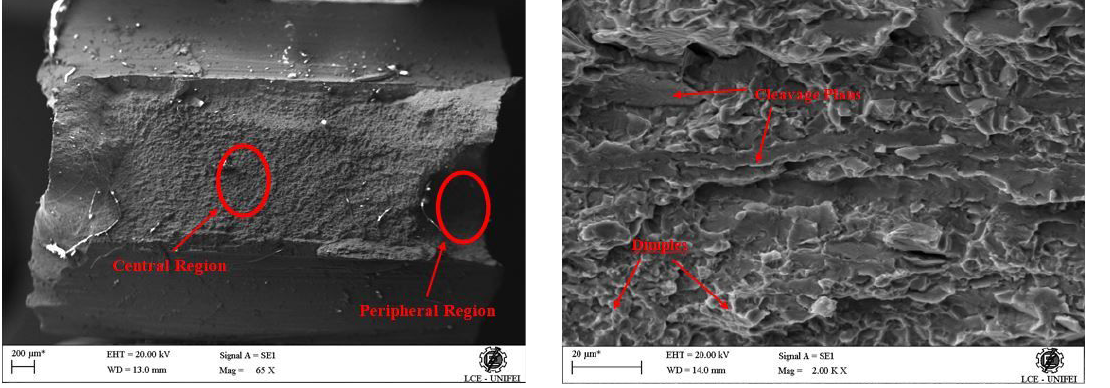
Figure 7. SA Sample: Mixed Fracture Aspect in Peripheral Region.